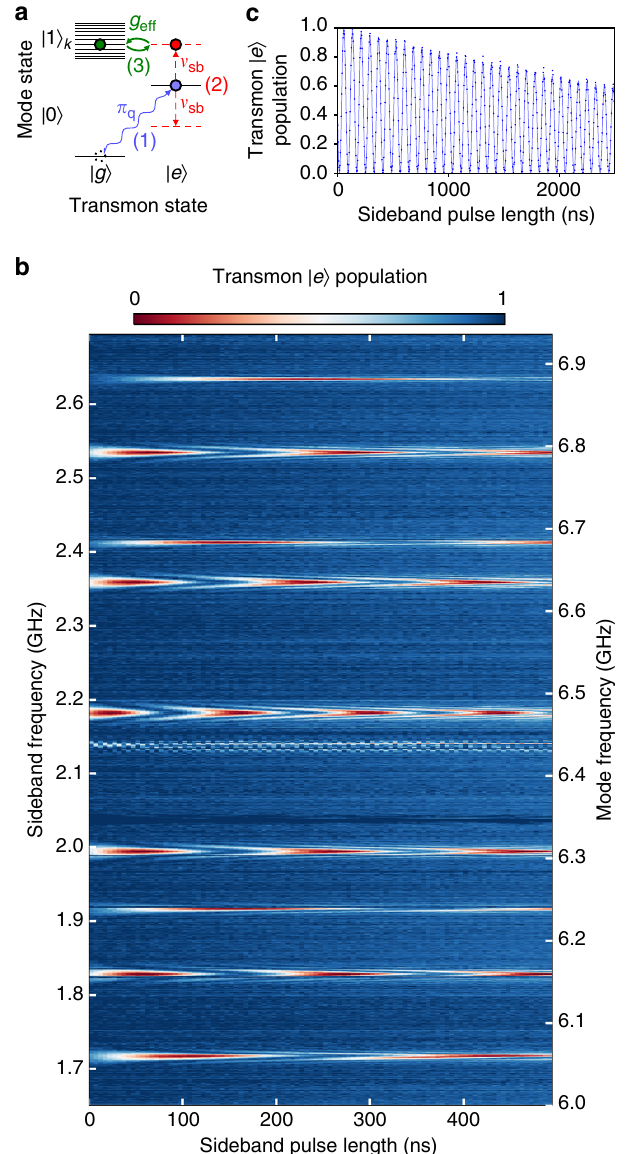
Fig. 2 Stimulated vacuum Rabi oscillations. a Generation of stimulated is the state with a single photon in mode k ; all vacuum Rabi oscillations. 1 j i k other modes are in the ground state. (1) An excitation is loaded into the transmon via its charge bias. (2) The transmon frequency is fl ux-modulated to create sidebands. (3) When a sideband is resonant with a mode, single- photon vacuum Rabi oscillations occur between transmon and the mode. b Experimental results obtained from this protocol for a range of sideband modulation frequencies, with the transmon biased at v q = 4.28 GHz. The length of the fl ux modulation pulse is swept for each frequency and the excited state population of the transmon is measured after the pulse ends. Chevron patterns indicate parametrically induced resonant oscillations with each of the memory modes. Two of the eleven modes are weakly coupled to the transmon and are not visible at these fl ux modulation amplitudes. The distribution of the modes can be understood through Hamiltonian tomography 48 (Supplementary Note 9). c Resonant oscillations